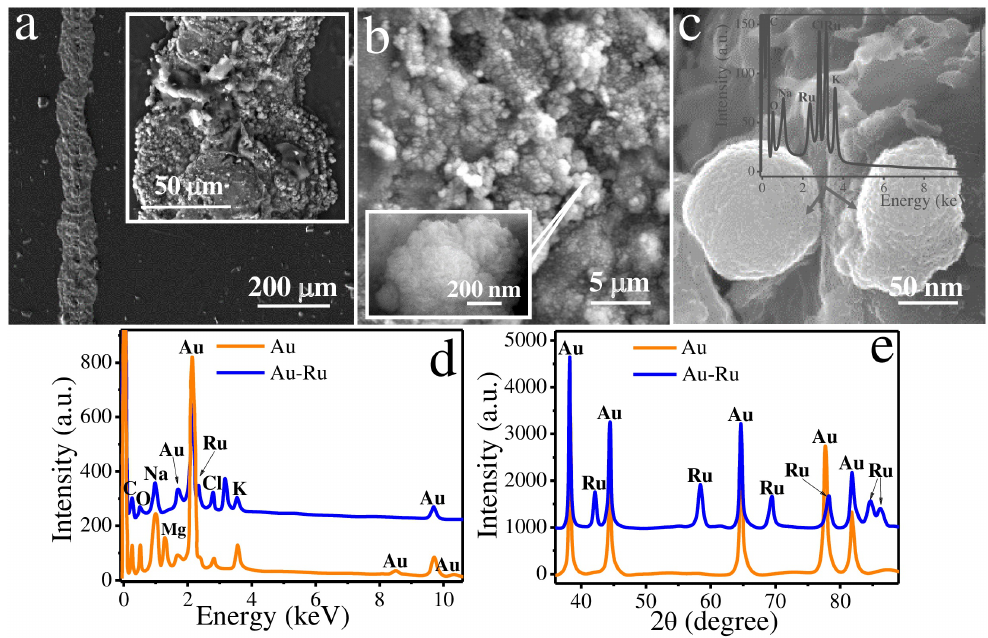
Figure 2. ( a – c ) SEM images of Au–Ru composite fabricated on glass. ( d ) EDX spectra and ( e ) XRD patterns of Au and Au–Ru microstructures. Morphological analysis demonstrated that the electrode material consists of porous gold microstructures with ruthenium particles irregularly distributed on their surface. These Ru particles have a highly developed structure with small zigzag cracks and exist in the form of either spherical droplets with a diameter of 70–150 nm ( c ) or their agglomerates with a size of several hundred nanometers ( b , inset). EDX analysis showed that the main elements of the Au–Ru deposit are gold and ruthenium with weight percentages (wt.%) of 53 and 21, respectively. In addition, the surface of the synthesized composite was also analyzed using the XPS method (Figure 3). Figure 3a presents two asymmetric peaks at ∼ 84 and ∼ 87.7 eV in the Au4f region with typical spin-orbit splitting of ∼ 3.7 eV [41] confirming the presence of Au 0 . On the other hand, Figure 3b reveals a doublet (asymmetric Ru3d 5/2 and Ru3d 3/2 peaks at ∼ 279.8 and ∼ 284.0 eV, respectively) in the Ru3d region with significant spin-orbit splitting of ∼ 4.2 eV, which can be assigned to the metallic ruthenium Ru 0 state [42]. Broadening of the Ru3d 3/2 peak can be due to strong overlap between the Ru3d and C1s regions [43].